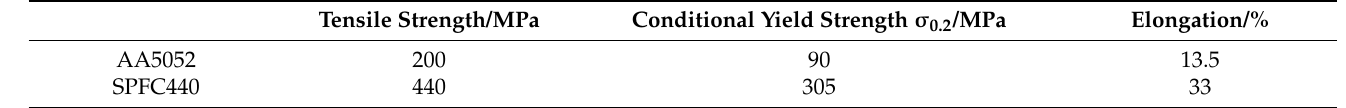
Table 2. Mechanical properties of AA5052 and SPFC440. Tensile Strength/MPa